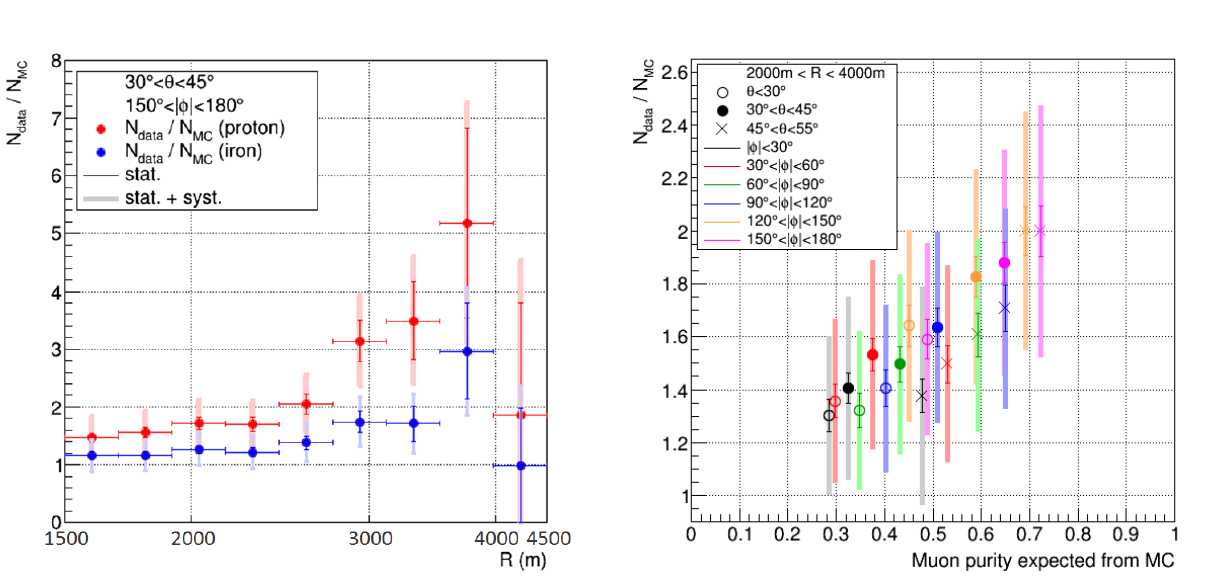
Figure 5. The correlation between the muon purity and the ratio of the signal size of the data to the MC with QGSJET II-03 for 2000 m < R < 4000 m [28]. The vertical thin error bars and shaded thick error bars represent statistical errors and quadratic sums of statistical and systematic errors,